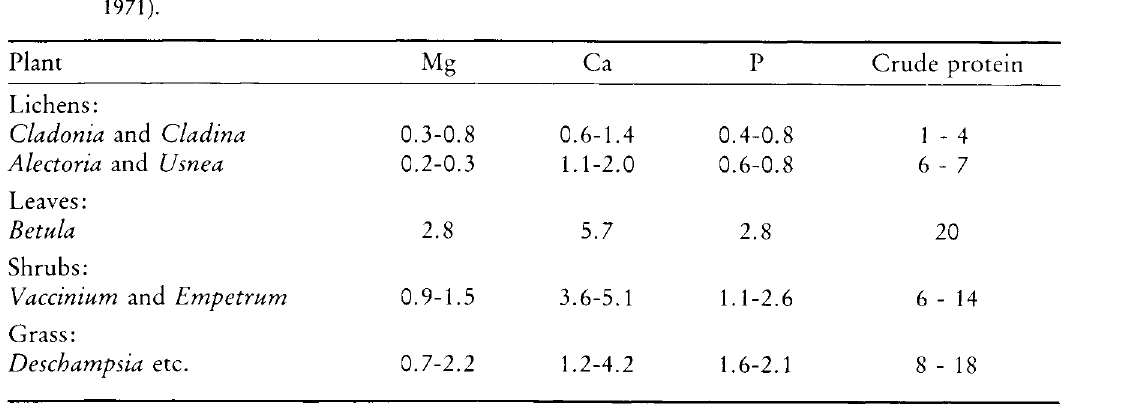
Table 1. Macromineral and crude protein content (g/kg dry matter) in some reindeer forage plants (Isotalo, 1971).